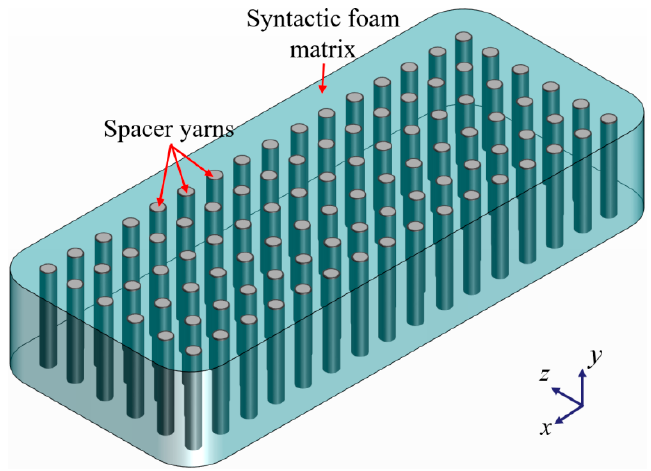
Figure 3. The equivalent model of WKSF-synthetic foam (SF).